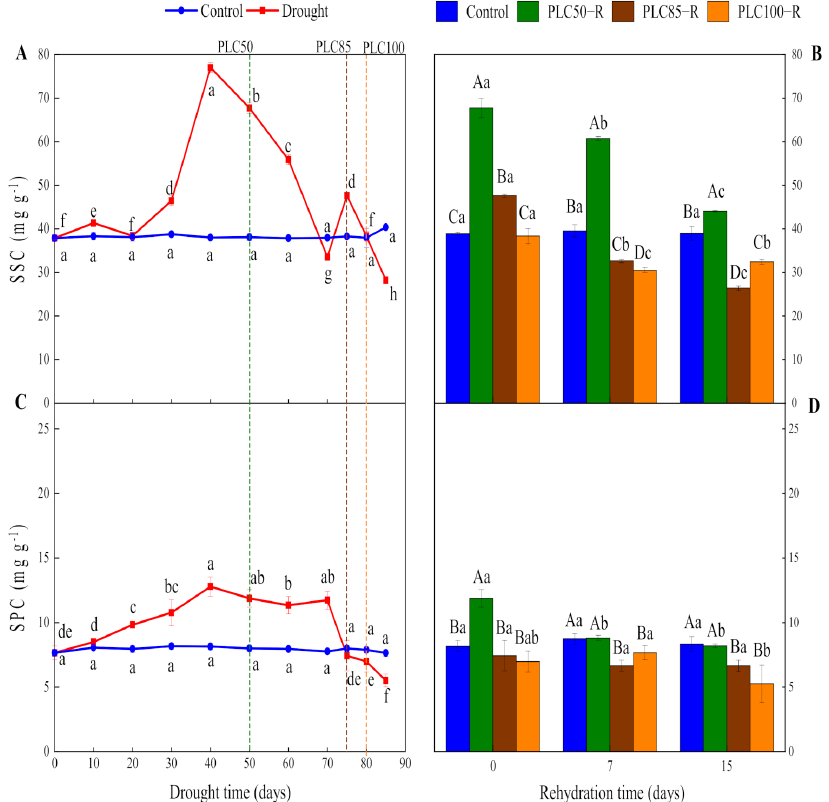
Figure 3. Dynamics of soluble sugar and soluble protein concentration in Pinus massoniana seedlings after drought and subsequent rehydration. Panels ( A , C ) represent the dynamics of SSC and SPC under drought treatment, and panels ( B , D ) represent the dynamics of SSC and SPC after subsequent rehydration. Different lowercase letters indicate significant differences between sampling dates within the same treatment ( p < 0.05), while different capital letters indicate significant differences between treatments on the same sampling date ( p < 0.05). Dashed lines represent the time when PLC reached 50% (PLC50, green), 85% (PLC85, brown), or 100% (PLC100, orange), while rehydration (PLC50 − R, PLC85 − R, and PLC100 − R) followed immediately. Values represent means ± SDs ( n =